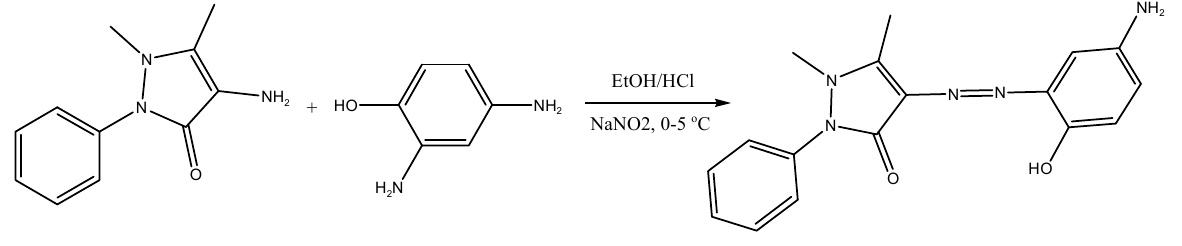
Figure 1. The proposed structure of azo dye ligand (L).